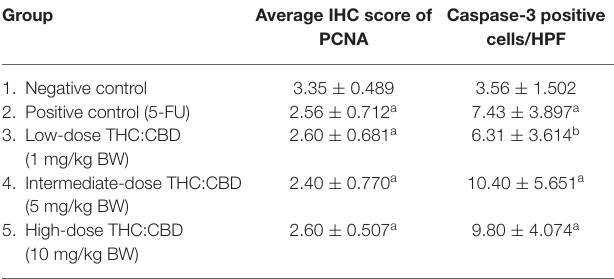
TABLE 4 | The expression score of PCNA and the average caspase-3 positive cells. Group Average IHC score of